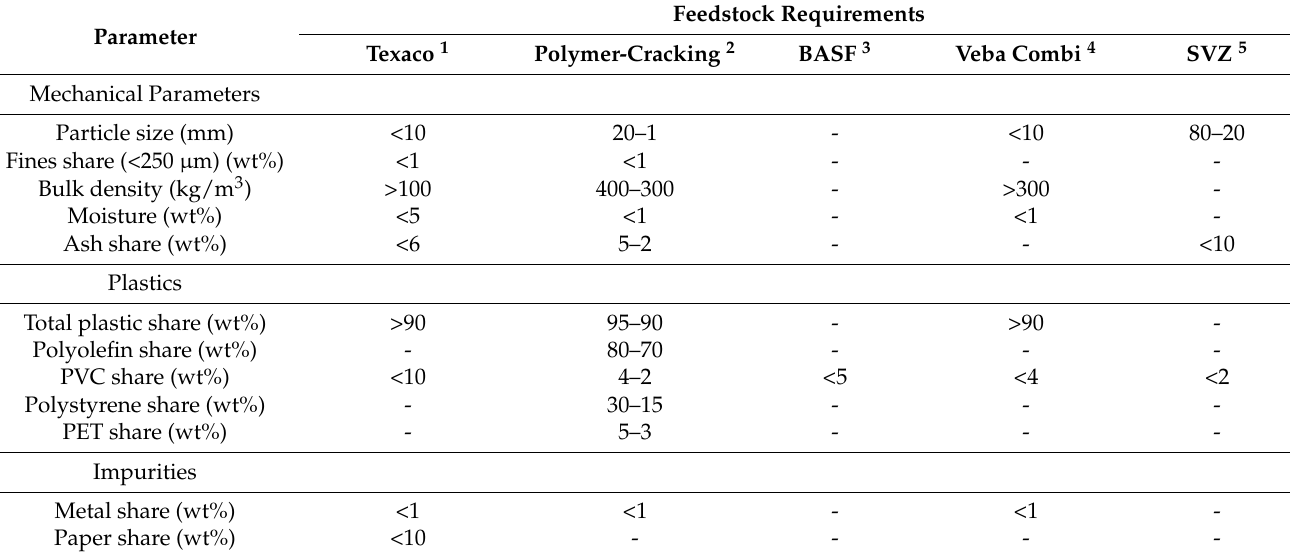
Table 6. Feedstock requirements for different chemical recycling processes